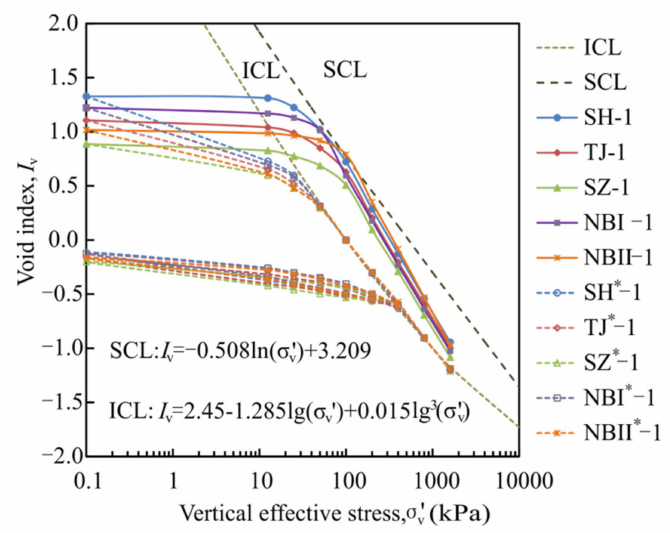
Figure 9. Void index I v versus varied vertical e ff ective stress σ v ’. ICL: intrinsic compression line; SCL: sedimentation compression